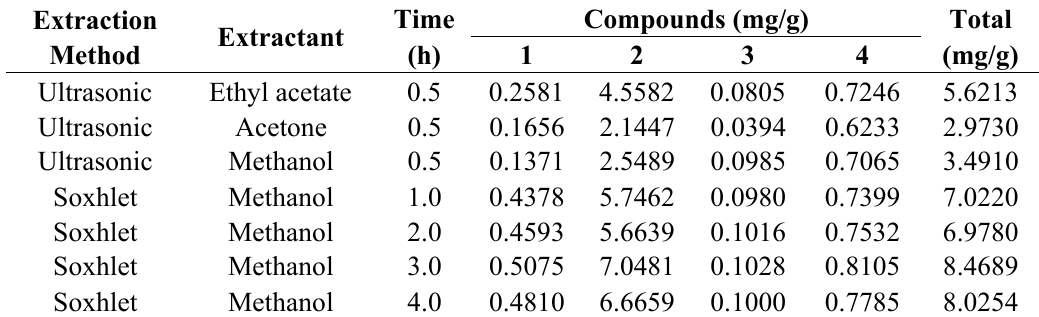
Table 1. Optimization of extraction method of